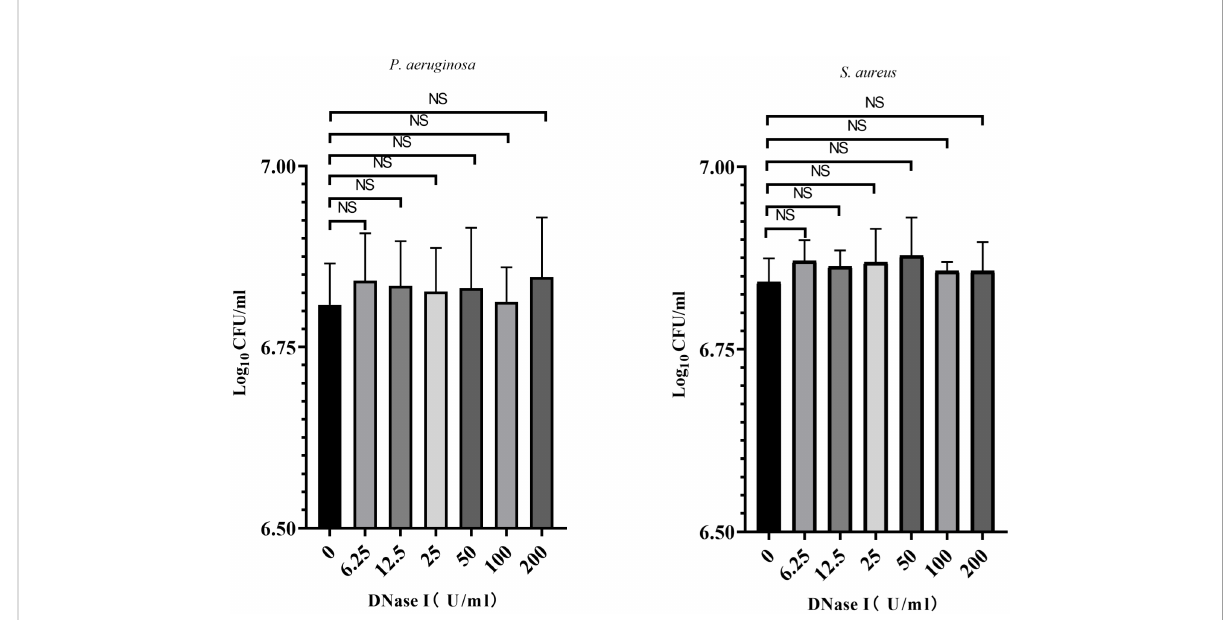
FIGURE 3 Bio fi lm bacterial counts were obtained after exposure to DNase I for 24 h. The results are presented as mean ± SD. NS indicates p- values > 0.05, compared with the results of the drug-free control group using one-way ANOVA (n =